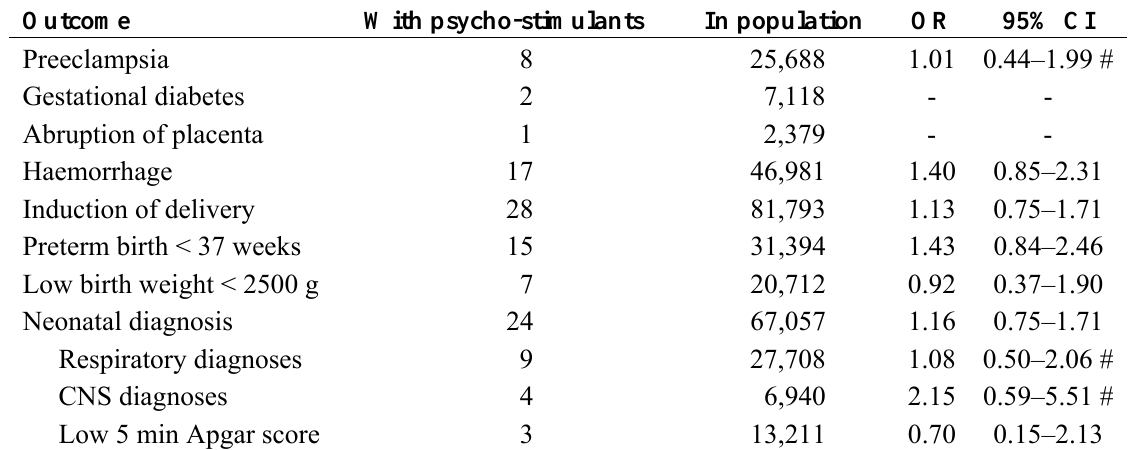
Table 39. Outcomes after maternal use of psychostimulants during the 2nd or 3rd trimester. Outcome With psycho-stimulants In population OR 95% CI Preeclampsia 8 25,688 1.01 0.44–1.99 # Gestational diabetes 2 - Abruption of placenta Haemorrhage Induction of delivery Low birth weight < 2500 g Neonatal diagnosis Respiratory